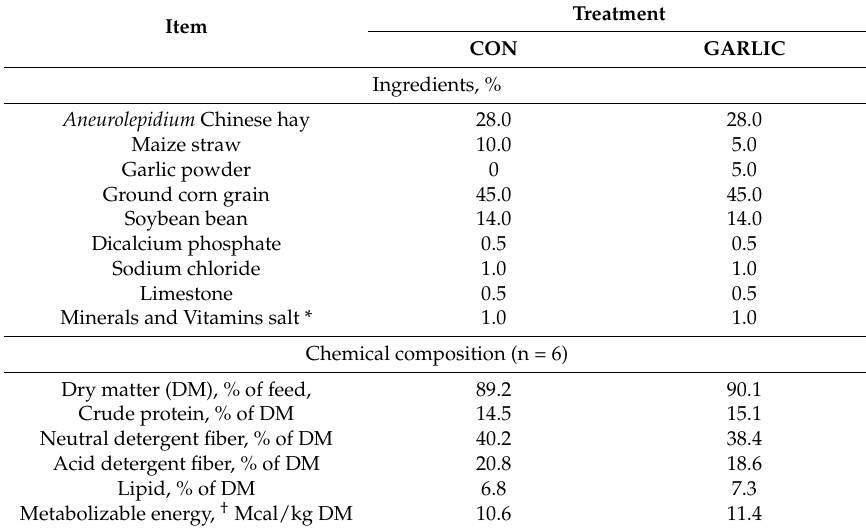
Table 1. Ingredients and chemical composition of the experiment’s diets.